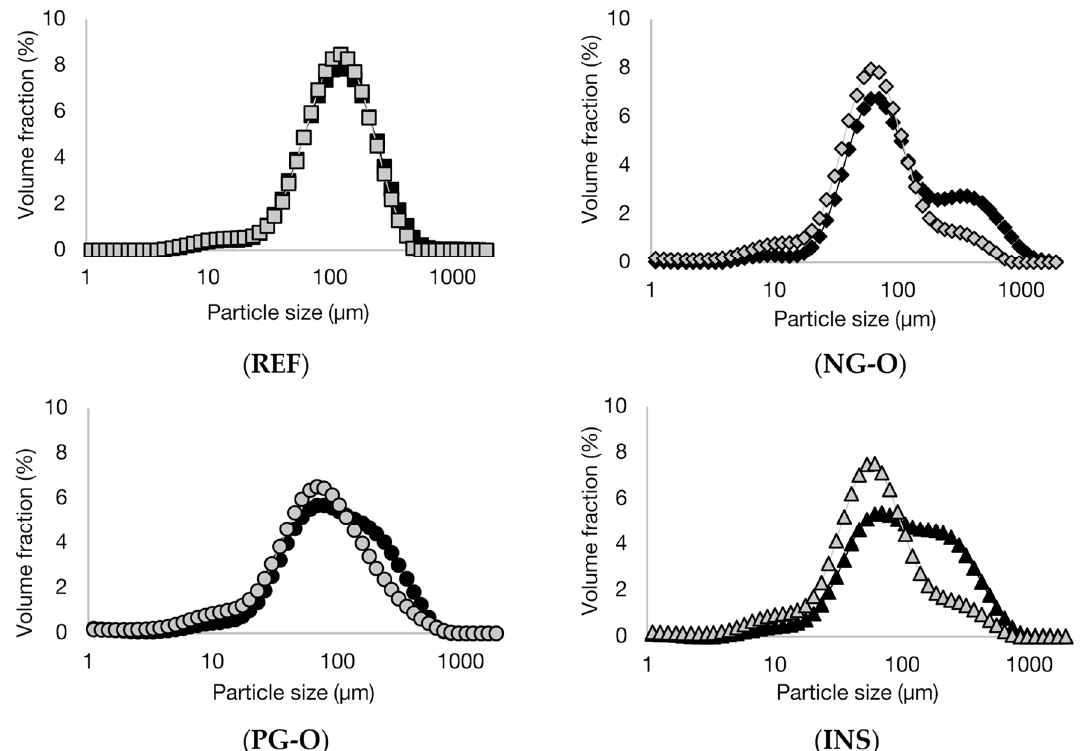
Figure 5. Volumetric particle size distributions of reference soup containing potato starch (REF), and chickpea flour soups containing non-gelatinised open cell flour (NG-O), pre-gelatinised open cell flour (PG-O), and pre-gelatinised commercial chickpea flour (INS) suspended in boiling water without (black symbols) and with sonication (grey symbols).